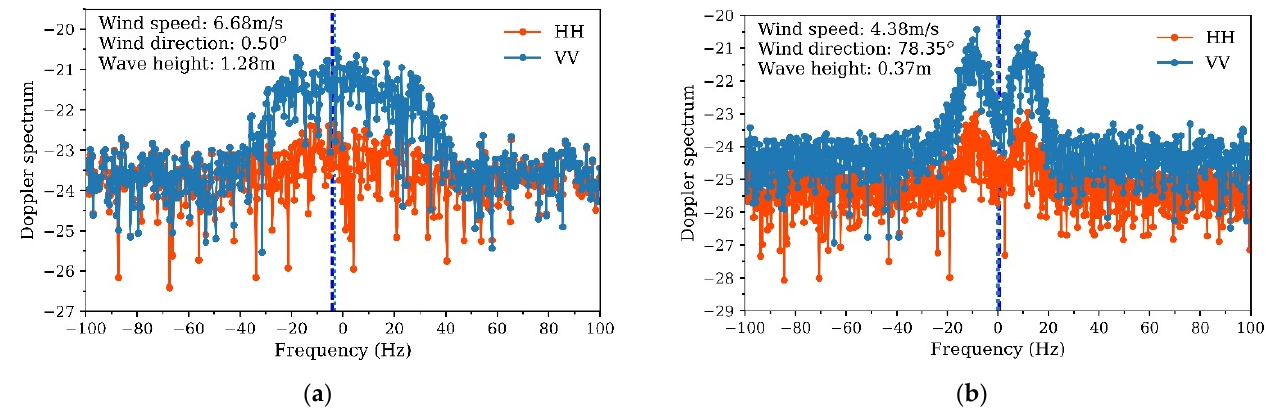
Figure 13. Characteristics of Doppler spectrum distribution under different wind directions in X-band. ( a ) Wind direction: 0.5 ◦ ; ( b ) Wind direction: 78.35 ◦ .